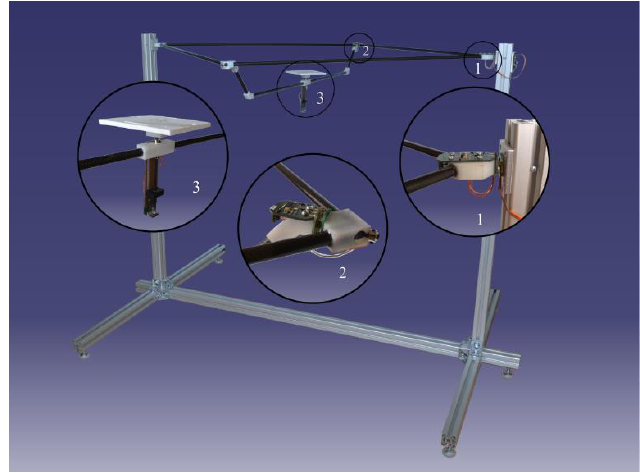
Figure 5. Prototype of the test stand.